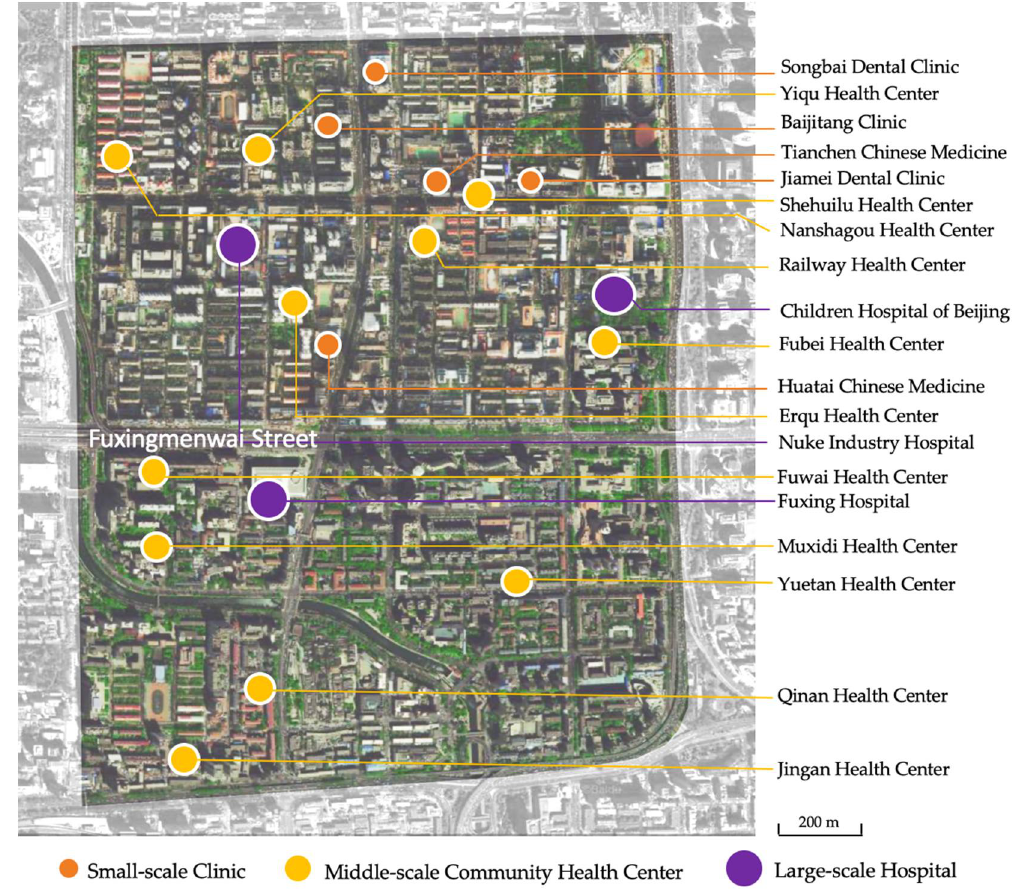
Figure 5. Healthcare facilities in Yuetan Area.